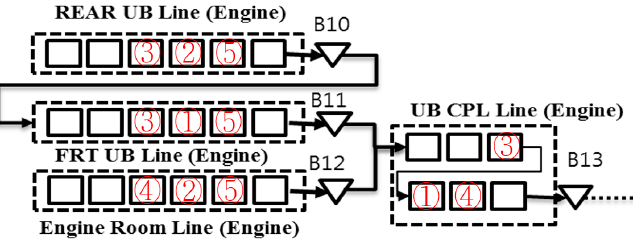
Figure 2. Positions of workstations to be eliminated in the underbody line for engine